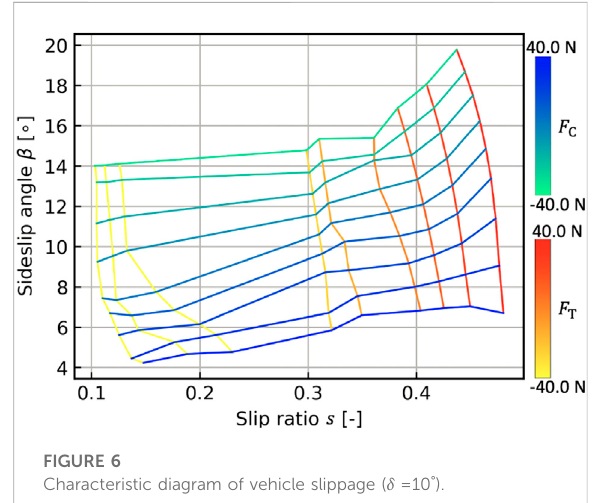
FIGURE 5 Wheel – soil contact force on a sloped terrain.